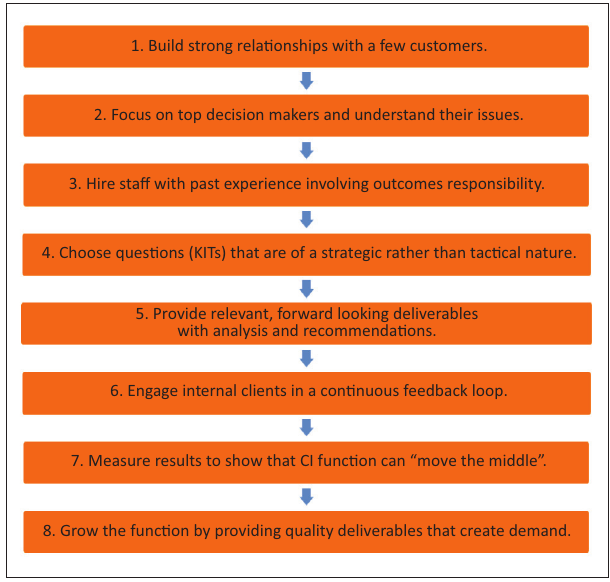
FIGURE 3: Hallmarks of excellence in competitive